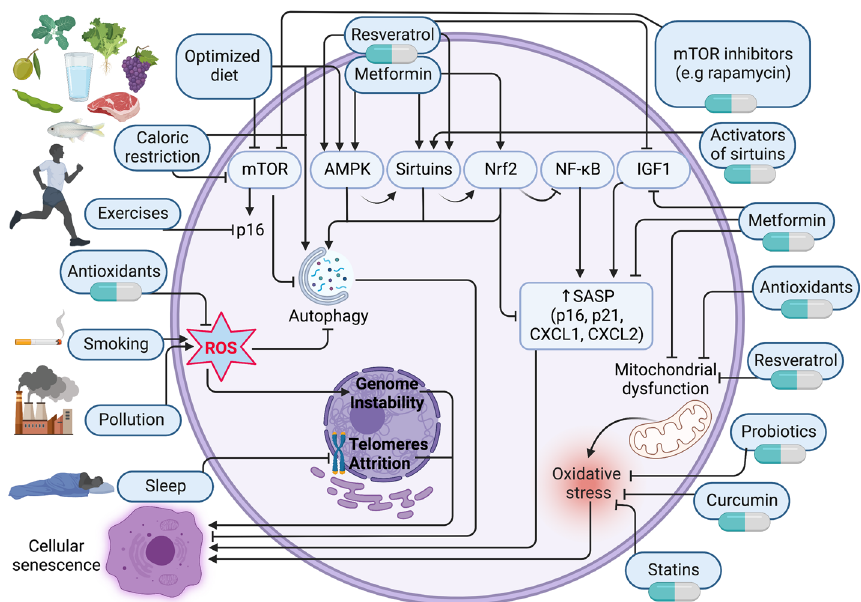
Fig. 6 Lifestyle modifications and pharmacological interventions are strategies to combat aging and cellular senescence. Optimizing lifestyle with appropriate diet, exercise, sleep, and no smoking and pollution is critical to avoiding aging and cellular senescence. Pharmacological interventions by metformin, resveratrol, curcumin, statins, antioxidants, mTOR inhibitors, sirtuins activators, caloric restriction mimetics, and probiotics are also suggested as anti‑aging remedies. Activate,